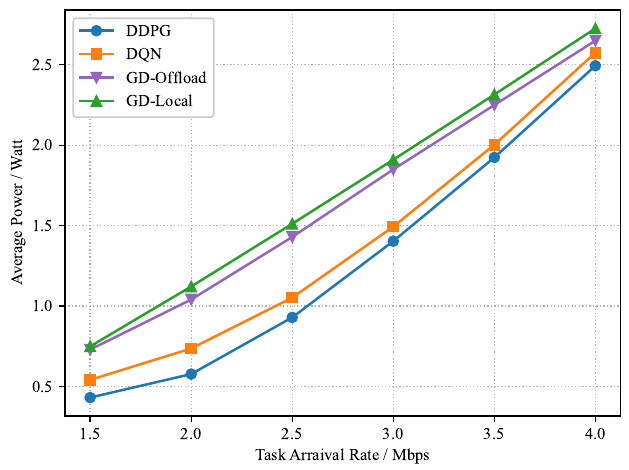
Figure 8. Average power consumption versus task arrival